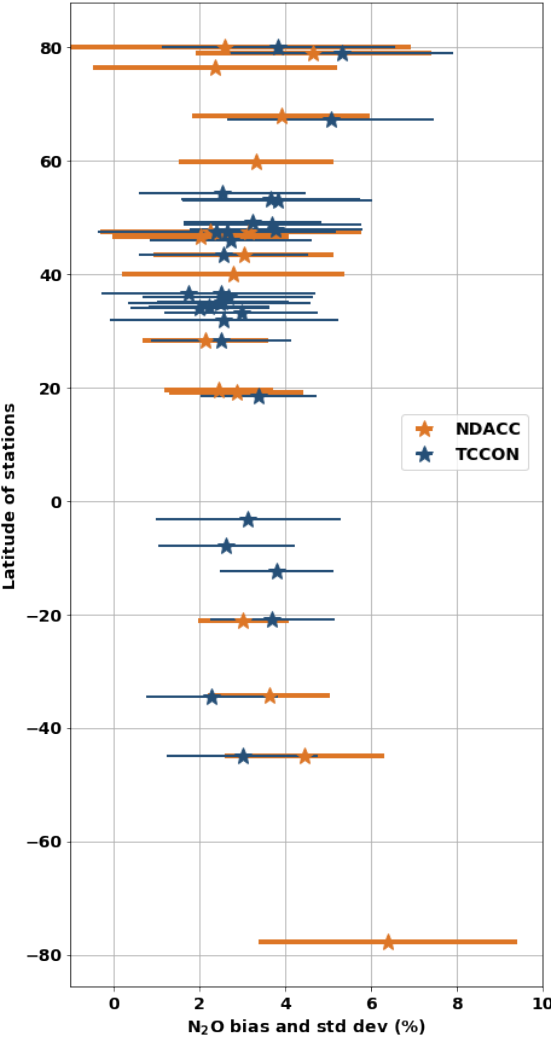
Figure 20. Mean relative bias and standard deviations (std dev) of IASI NOPIR N 2 O at NDACC and TCCON stations, for comparisons from 30 September 2014 to 31 December